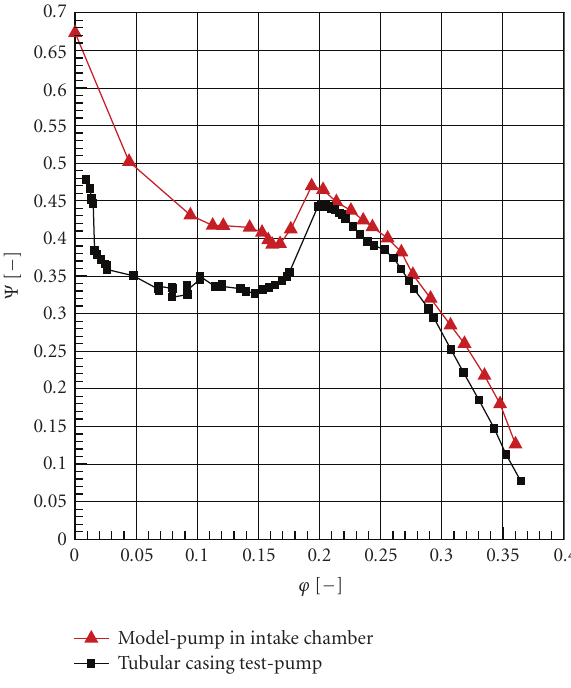
Figure 5: Head characteristic without casing treatment of model-pump (DN 150) installed vertically in intake chamber and horizontal tubular casing test-pump (DN 350) used by